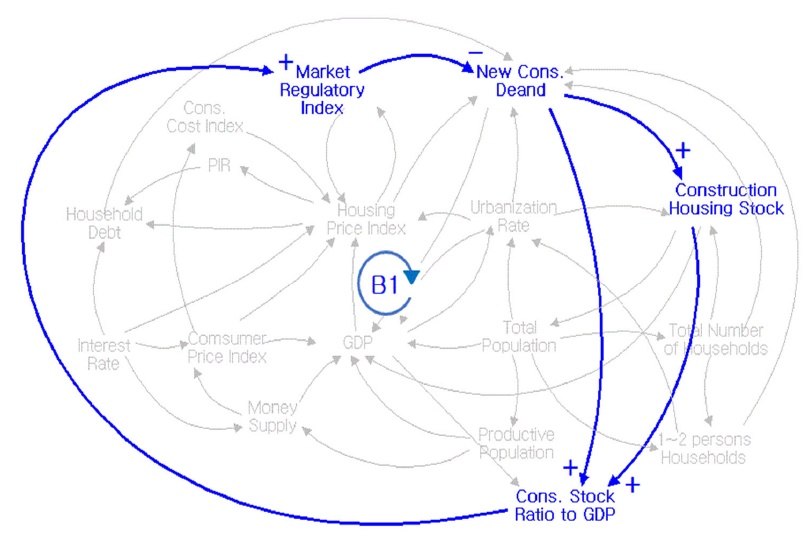
Figure 2. Loop in the influence of residential construction market on market regulation.